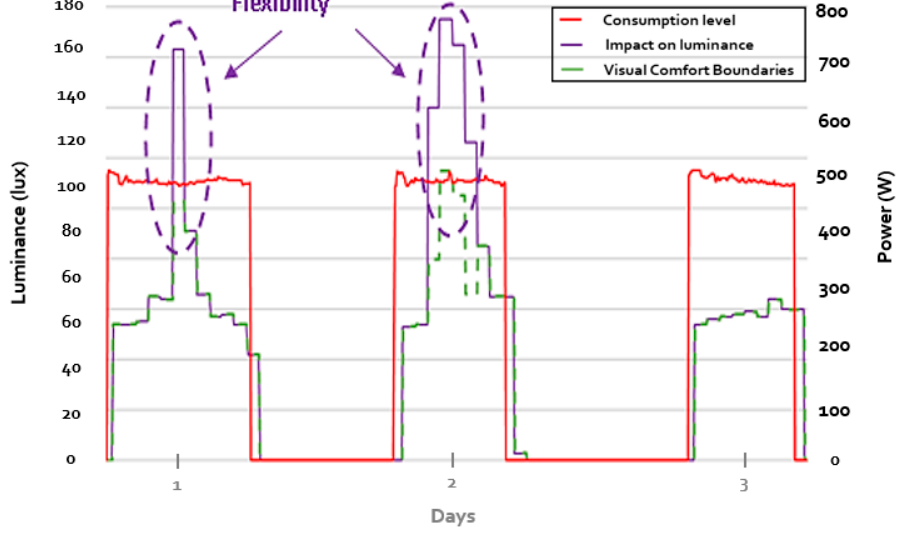
Figure 12. Visual comfort flexibility.